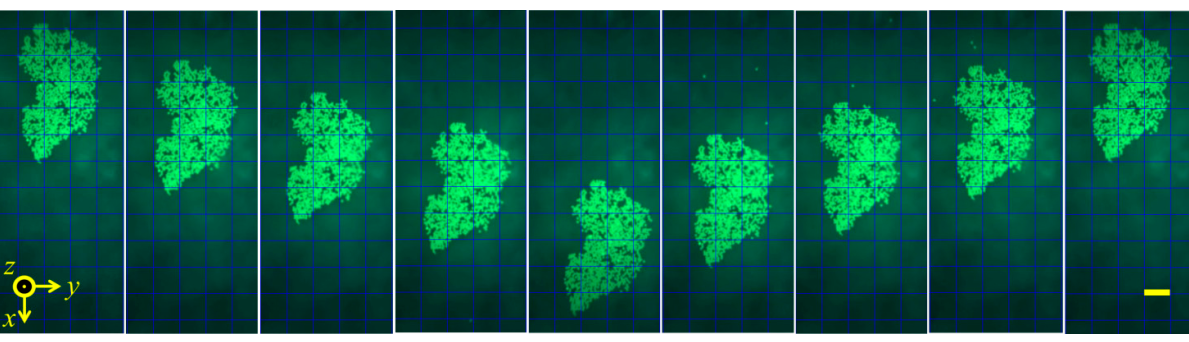
Figure 21. An agglomerate formed by activating three adjacent elements of the array is transported along the length of the capillary channel by altering the activated elements with a step size of one element. Scale bar = 100 μm.